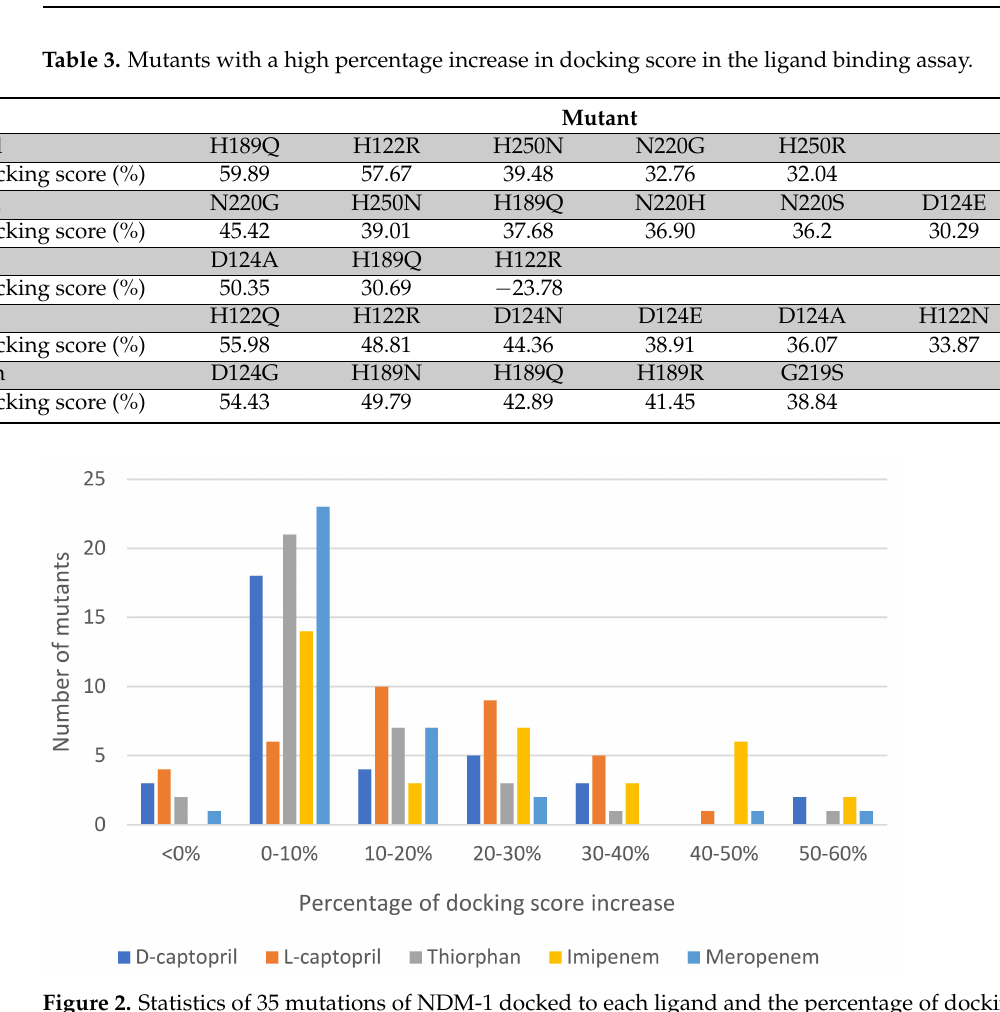
Figure 2. Statistics of 35 mutations of NDM-1 docked to each ligand and the percentage of docking score